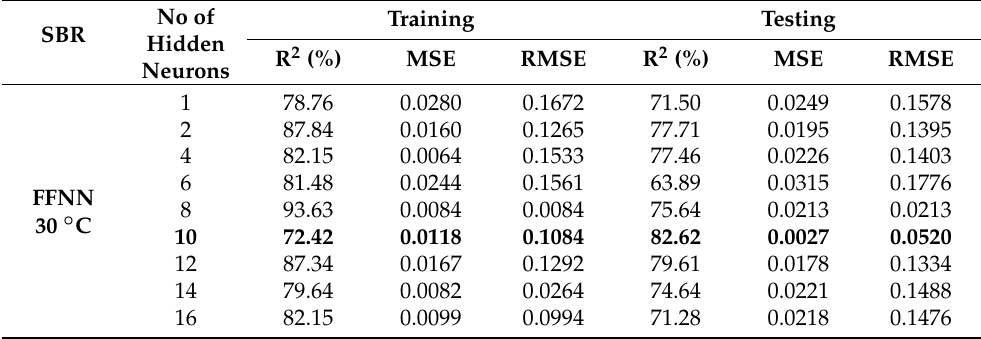
Table 3. Performance of FFNN models for training and testing with different hidden neurons (the best model is in